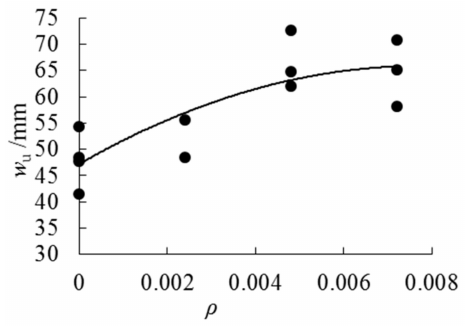
Figure 10. Ultimate deflection–cloth ratios trend curve.